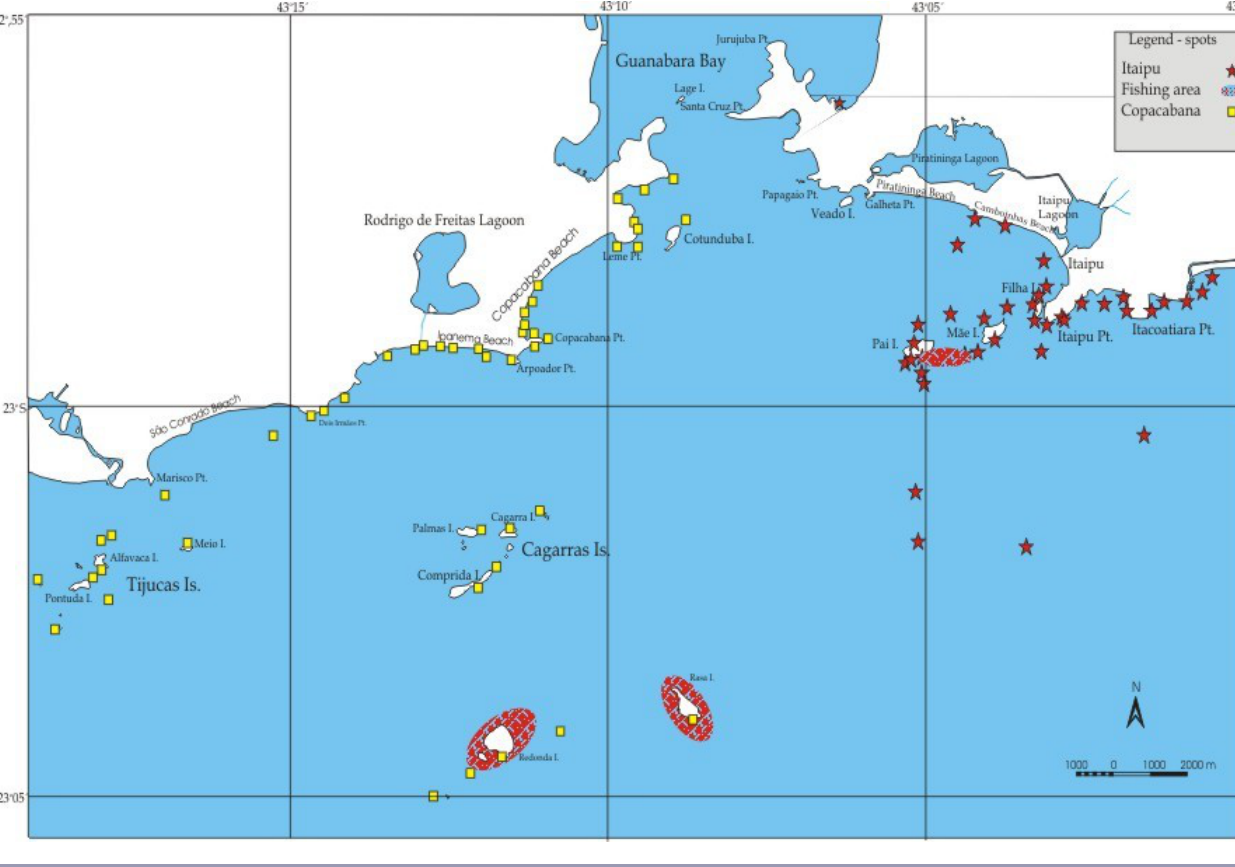
Fig. 2 . Fishing spots used by fishers from Copacabana Beach, marked in 1998 at Colônia de Pescadores Z-13, Rio de Janeiro State, and Itaipu Beach, marked in 2002–2003 at Colônia de Pescadores Z-7, Niterói, Rio de Janeiro